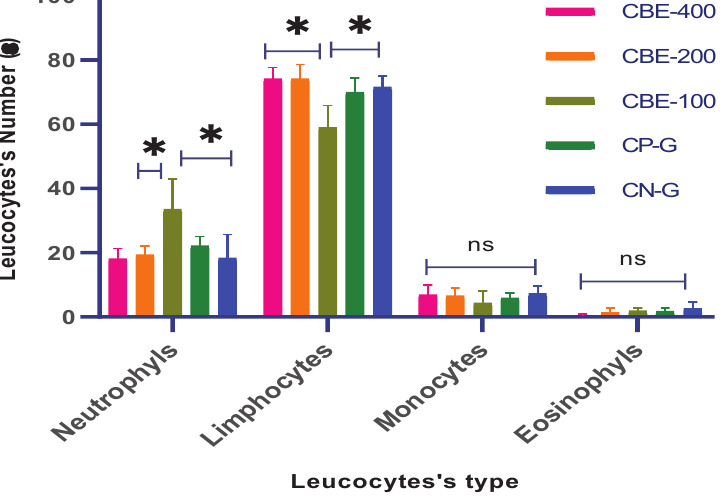
Figure 1 . Leucocyte count in each group. Mann Withney Analysis: * p<0.05; ns not significant